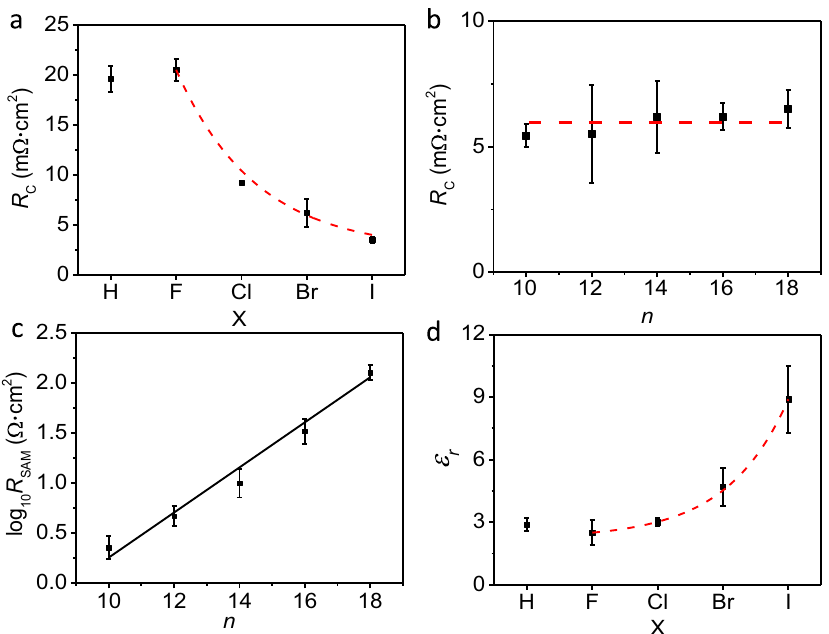
Fig. 4 Characterization of junctions with impedance spectroscopy. a Contact resistance R C vs. X for Ag – S(CH 2 ) 14 X//GaO x /EGaIn junctions at DC of 0 V and sinusoidal perturbation of 30 mV. Log-resistance of SAM, log 10 R SAM , ( b ) and R C ( c ) vs. n for Ag – S(CH 2 ) n Br//GaO x /EGaIn junctions. The solid black line represents a fi t to Eq. (2). d Corresponding dielectric constant ε r vs. X for Ag – S(CH 2 ) 14 X//GaO x /EGaIn junctions. The error bars are the standard deviations of three independent measurements. Dashed lines are visual